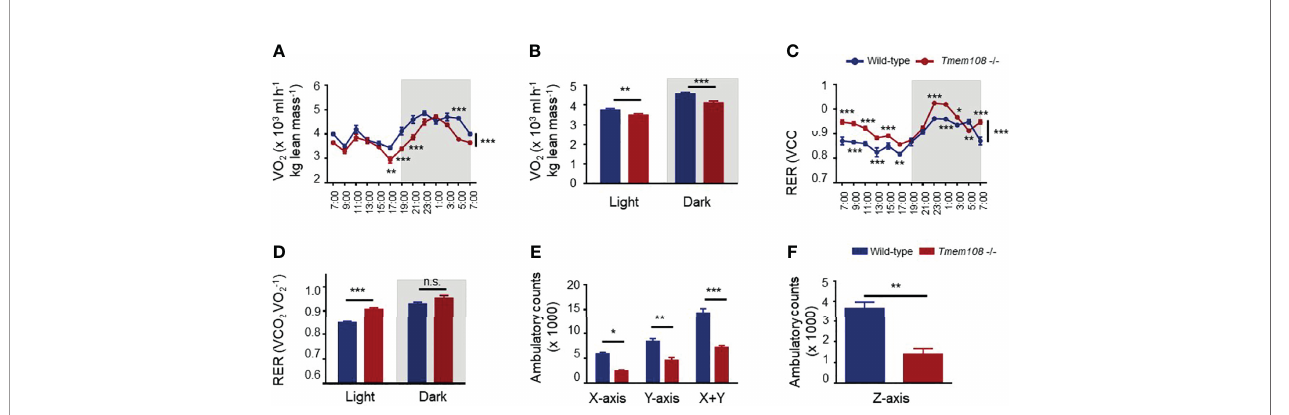
FIGURE 3 | Energy metabolism was remodeled in Tmem108 de fi ciency mice. (A) Determination of VO 2 in Tmem108 mutant ( Tmem108 -/-) mice over a 24-h period, normalized to body weight, wild-type mice as the control. (B) Consumption of VO 2 in Tmem108 mutant mice in 12-light and dark cycles was analyzed. (C) Determination of respiratory exchange ratio (RER) in Tmem108 mutant mice over a 24-h period. (D) RER of Tmem108 mutant mice in 12-h light and dark cycles were analyzed. (E) Ambulatory counts of mice in X-axis or Y-axis or both. (F) Ambulatory counts of mice in Z-axis. (Values are mean ± SEM, n = 8 per group, male mice; two-way ANOVA were performed between two curves in panel A and C; other statistics were unpaired t -test; n.s., not signi fi cant, *p < 0.05, **p < 0.01, ***p <